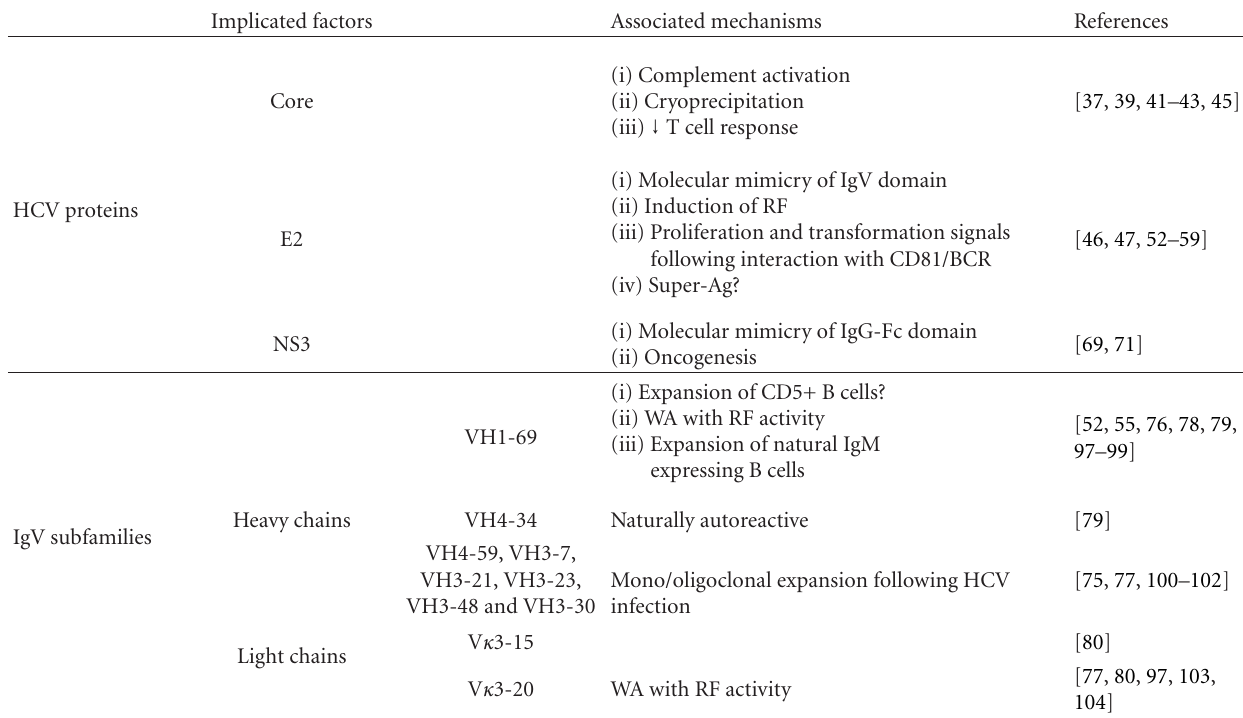
Table 1: Schematic representation of viral and humoral factors implicated in the instauration of HCV-related MCII and B-NHL. Implicated